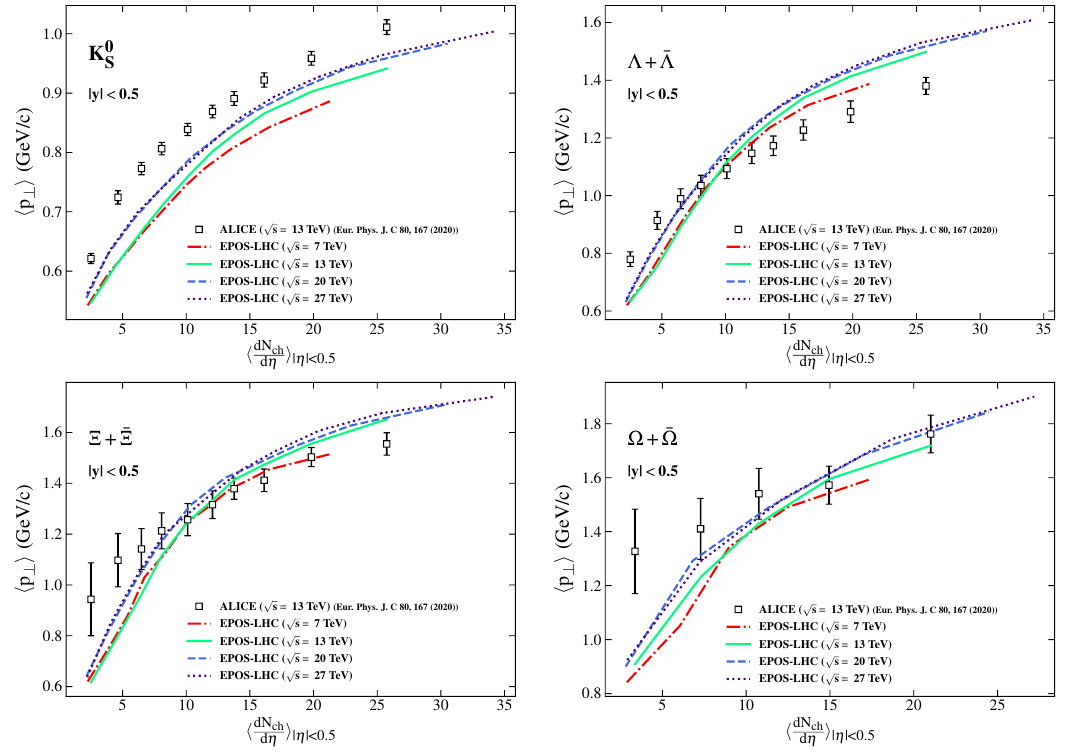
Figure 7. 13 TeV, 20 TeV, and 27 TeV using PYTHIA8 (Ropes model) [25].